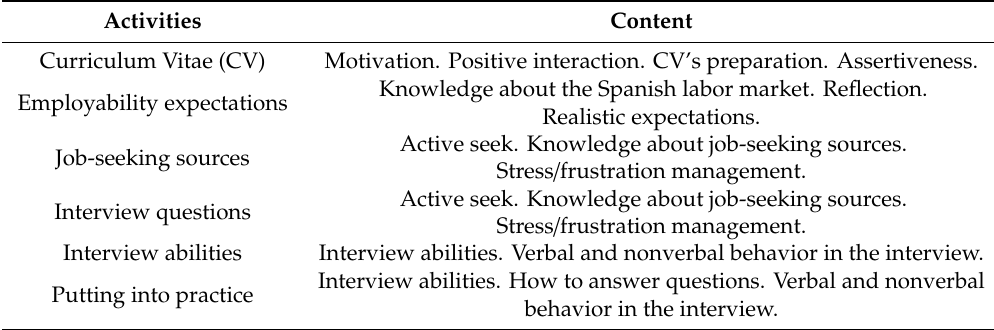
Table 3. Content of each session and number of